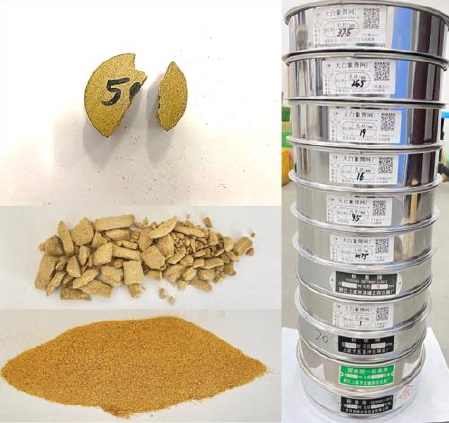
Figure 11. Grain size sieving and standard sieves.